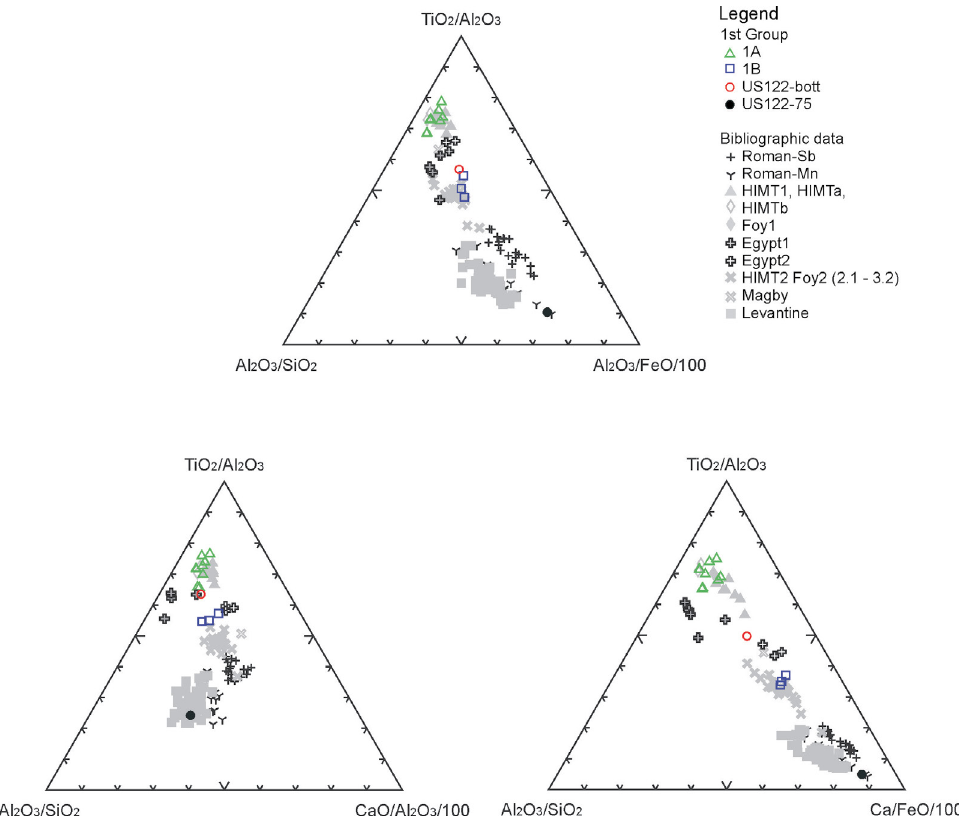
O/SiO vs. CaO/Al O binary plot. The sample US122-75 has been compared with the three Levantine known Figure 6: Na 2 2 2 3 primary production sites: Levantine I (Jalame 4 th century AD; and Apollonia 6 th –7 th century AD) and Levantine II (Bet Eli’ezer 8 th century AD).